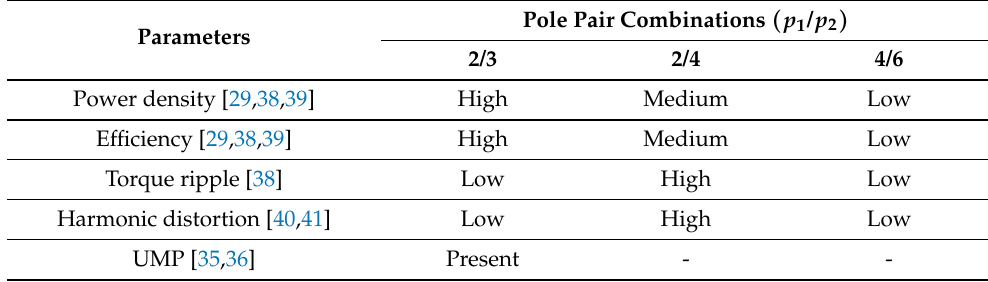
Table 1. Relative performance of popular BDFM pole pair